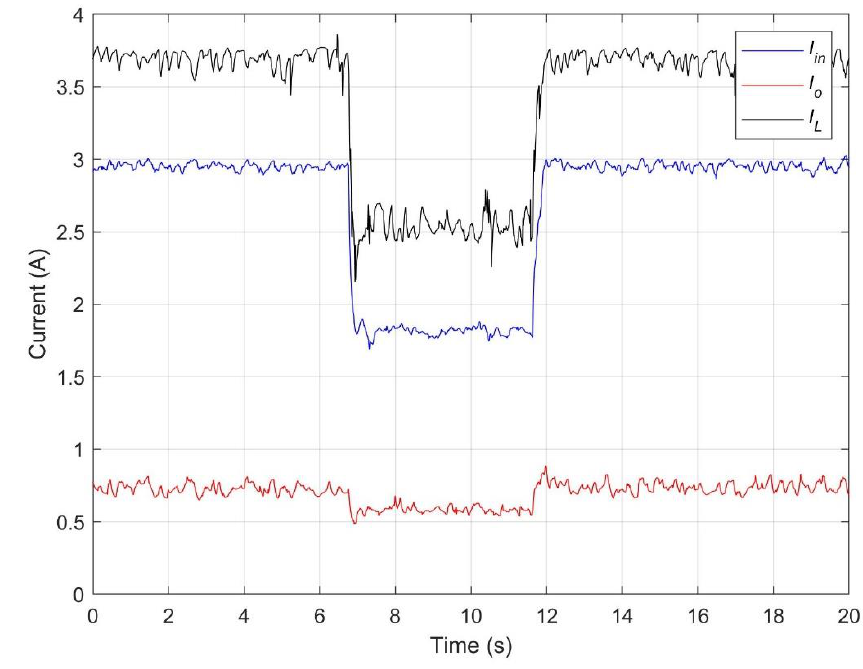
Figure 11. Evolution of the current at the DC/DC converter.